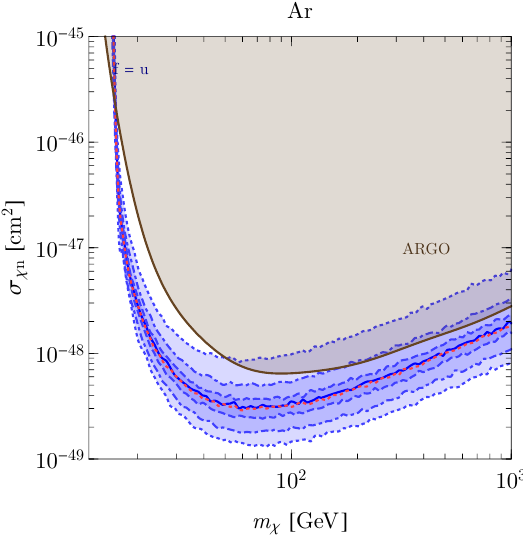
Figure 5.3: Neutrino discovery limit for the proposed ARGO experiment. The shaded regions correspond to predictions with NC-NSI ∆ χ 2 ≤ 1, 4,